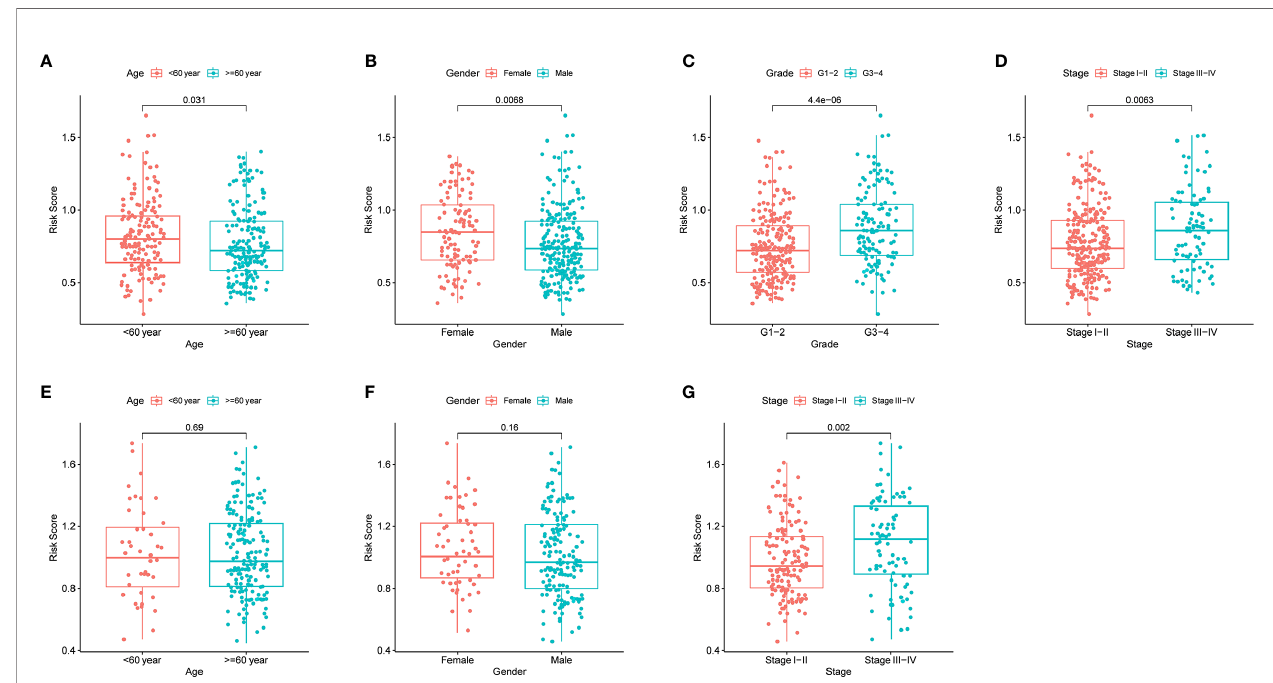
FIGURE 5 | The risk score in different groups divided by clinical characteristics. TCGA cohort (A – D) , ICGC cohort (E – F) . (A, E) Age. (B, F) Gender. (C) Tumor grade. (D, G) Tumor